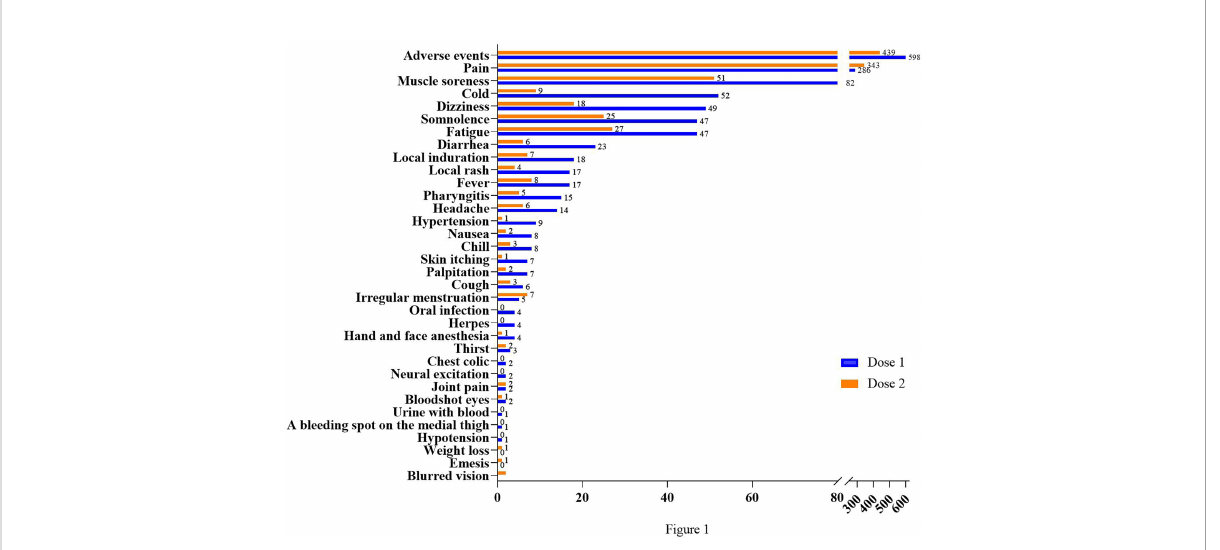
FIGURE 1 Comparison between frequencies of common adverse effects after two doses. The abscissa shows the number of cases; the ordinate shows different kinds of